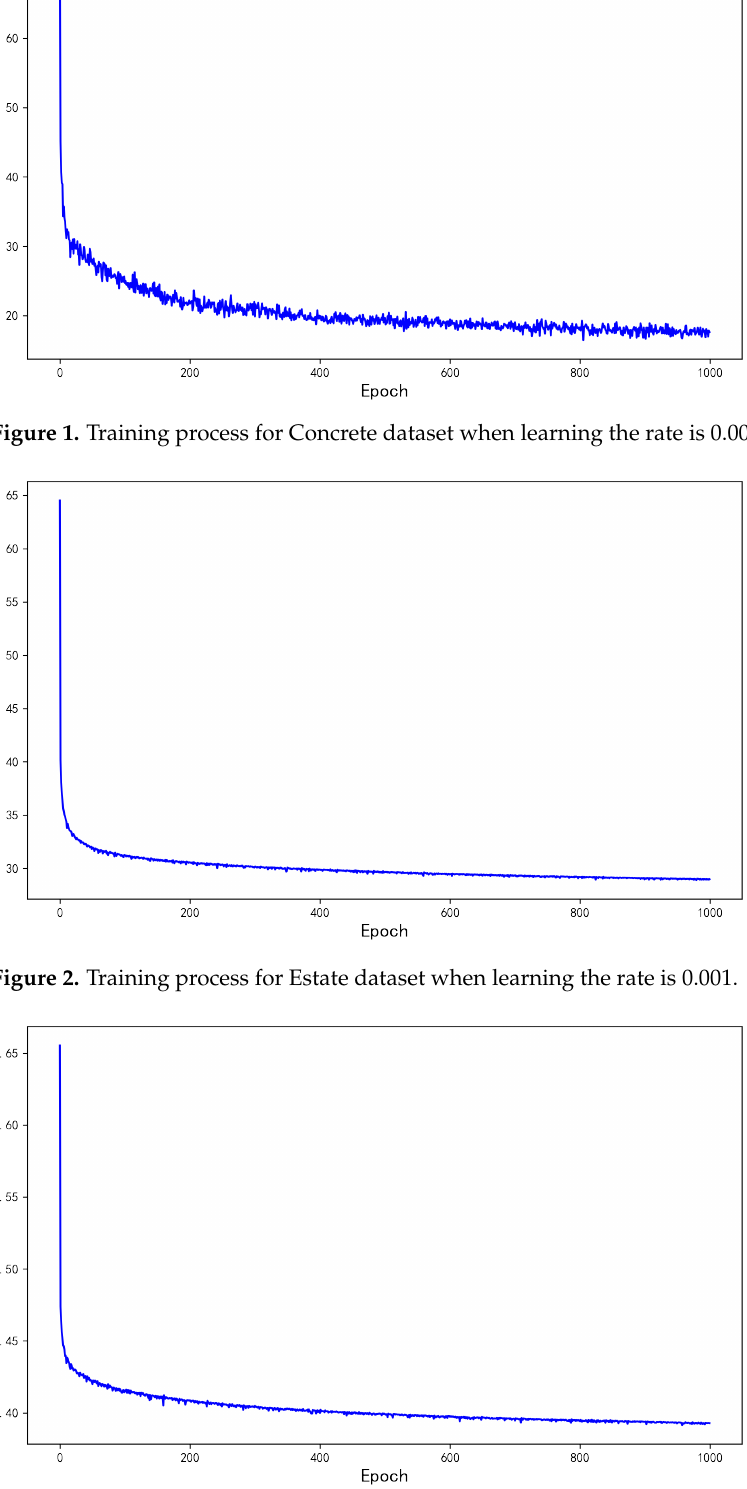
Figure 3. Training process for QSAR dataset when learning the rate is